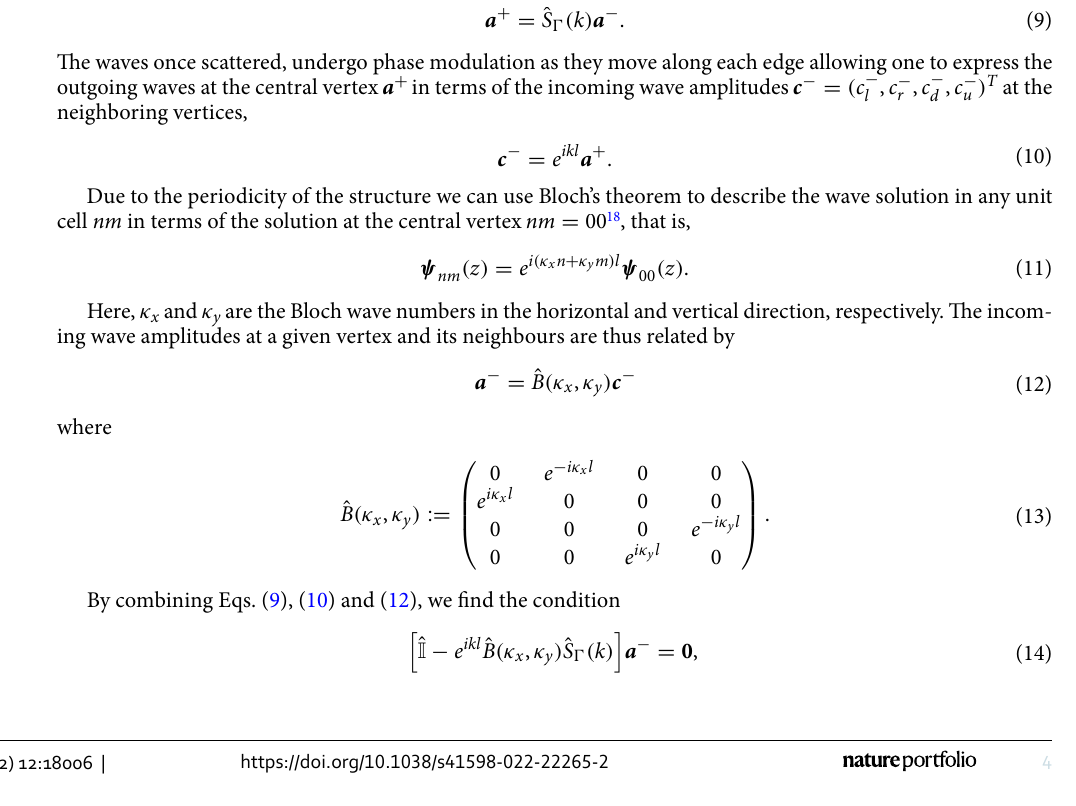
0 shown in the subplot with labeled m = =